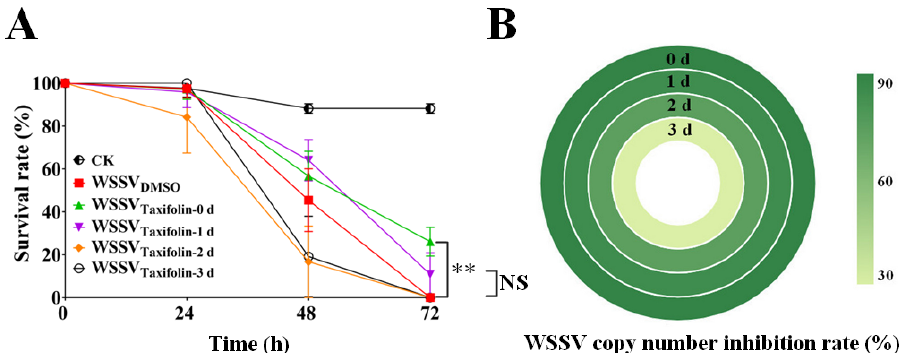
Figure 4. The half-life of taxifolin in aquacultural water was short. Taxifolin (100 µ M) was added to water and placed at 28 ◦ C for 0–3 d. On the final day, WSSV was premixed with each water sample to infect shrimp larvae. ( A ) Survivorship curves of WSSV-infected shrimp. ( B ) Quantification of copy number of the WSSV genome at 72 h was measured by qPCR. Each value was represented as the mean ± SD. The p value was determined by Student’s t -tests. ** p < 0.01; NS p > 0.05.